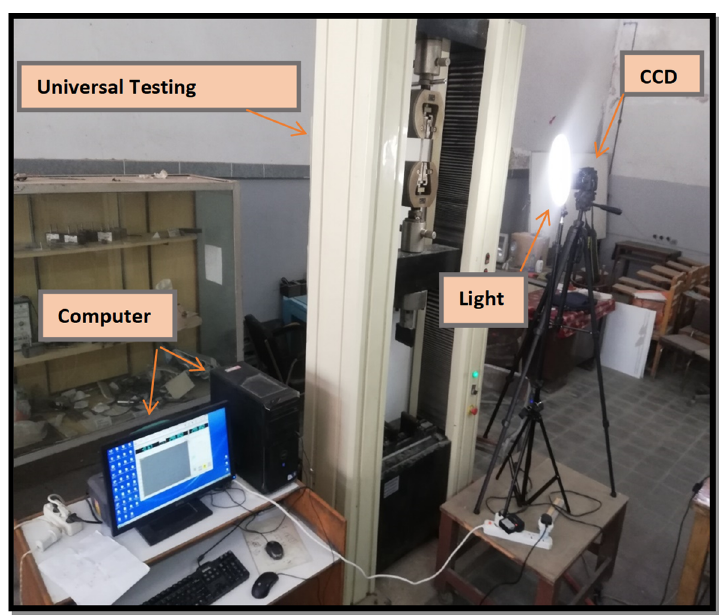
Figure 5. Experimental Setup.